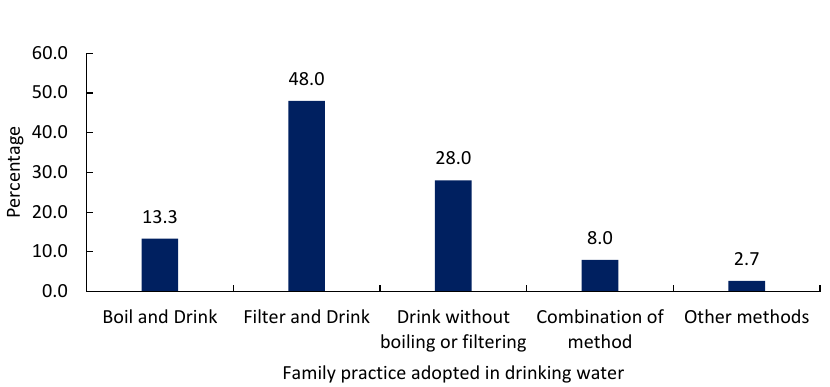
Fig 3: Different types of drinking water supply